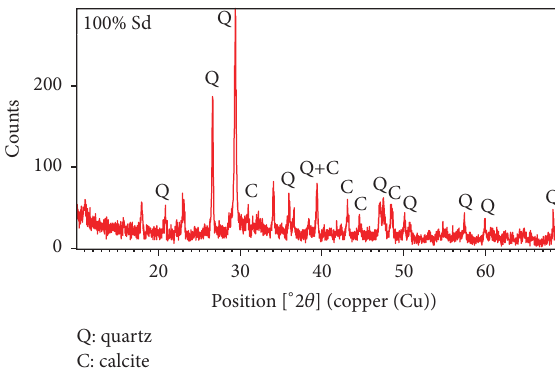
Figure 1: X-ray diffraction pattern for sand dune (K 𝑎 Cu radiation).